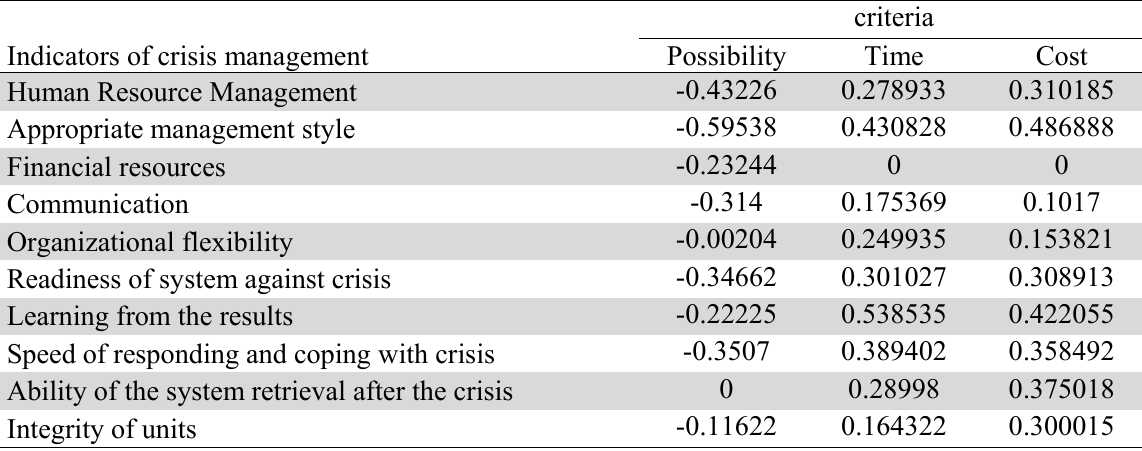
Weighted normal matrix